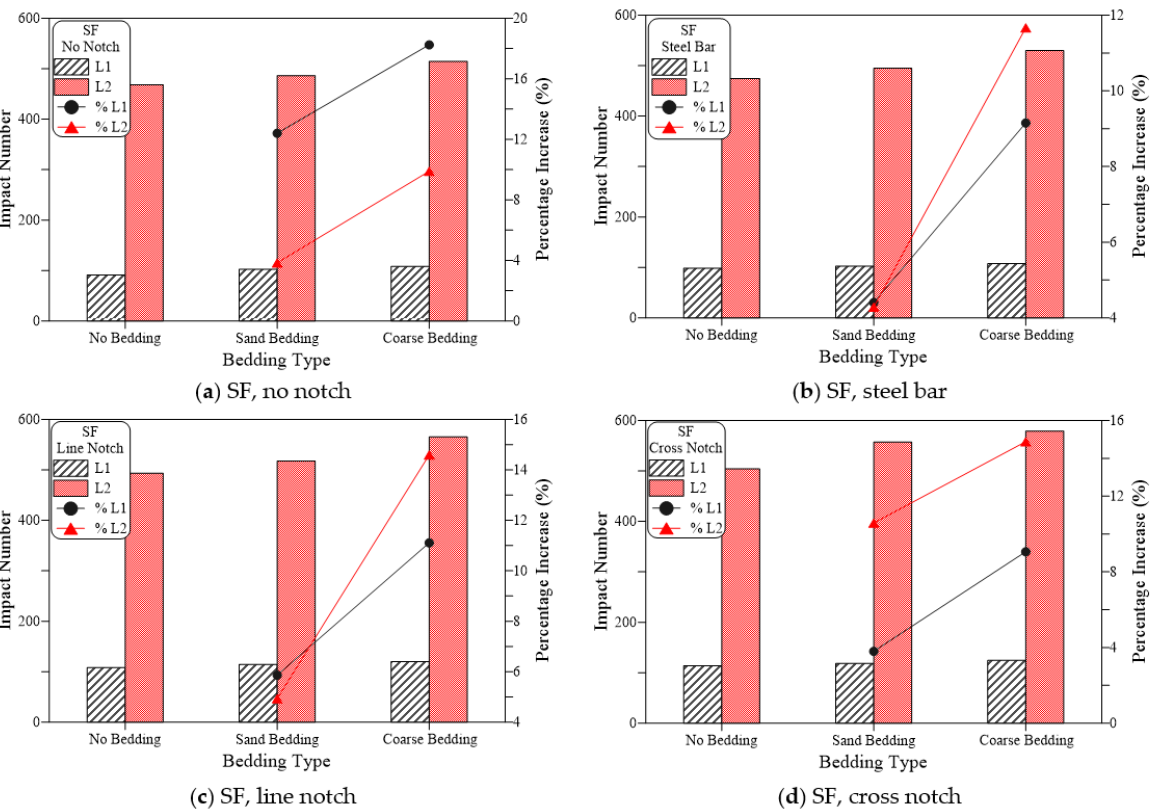
Figure 18. Bedding type effect on cracking and failure impact numbers of SF specimens ( a ) SF, no notch, ( b ) SF, steel bar, ( c ) SF, line notch ( d ) SF, cross